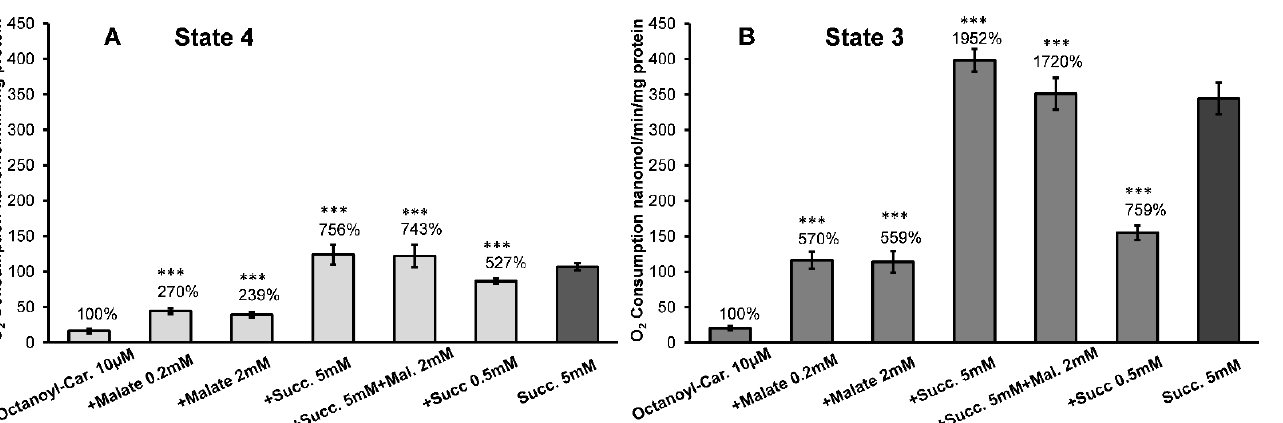
Figure 3. Effect of different concentrations of malate and succinate on oxidation of palmitoylcarnitine by the isolated kidney mitochondria. ( A ) Metabolic State 4; ( B ) Metabolic State 3. State 3 was initiated by adding 150 µM ADP. Incubation conditions as in Figure 1. The oxygen consumption rates by mitochondria oxidizing palmitoylcarnitine alone in the States 4 and 3 were taken as 100%. The actual respiration rates with 10 µM palmitoylcarnitine were: State 4, 18 ± 1.6, and State 3, 26 ± 1.8 nanomol O 2 /min/mg protein. Statistics: ** — p < 0.05; *** — p < 0.001. The number of experiments (separate isolations of kidney mitochondria) for each substrate: palmitoylcarnitine, n = 7; palm.-carn. + malate 0.2 mM, n = 7; palm.-carn. + malate 2 mM, n = 8; palm.-carn. + succinate 5 mM, n = 8; palm.-carn. + succinate 0.5 mM, n = 8; succinate 5 mM, n = 7.